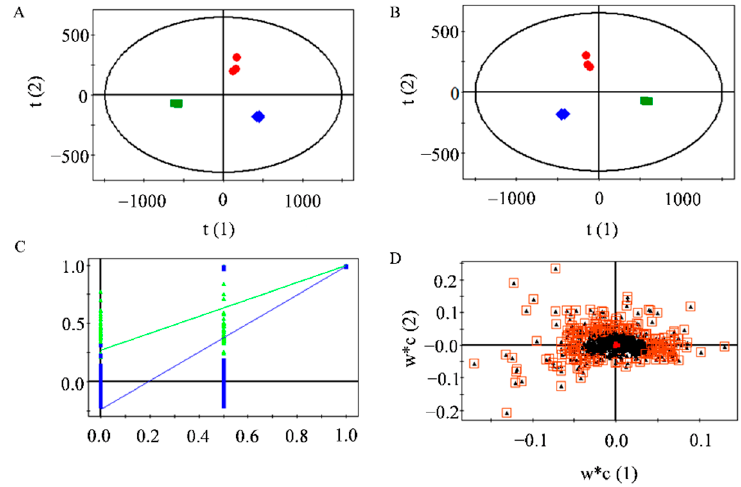
Figure 5. Multivariate statistical analysis of 30%MLF (squares), 50%MLF (circles), and 75%MLF (diamonds): ( A ) PCA score plot; ( B ) PLS-DA score plot, R 2 X = 0.91, R 2 Y = 0.99, Q 2 = 0.979; ( C ) cross-validation plot of the PLS-DA model with 100 permutations, R 2 = 0.273, Q 2 = − 0.236; and ( D ) PLS-DA loading plot—black triangles in boxes represent most differential metabolites. Table 3. Different flavonoids putatively identified among the MLFs.